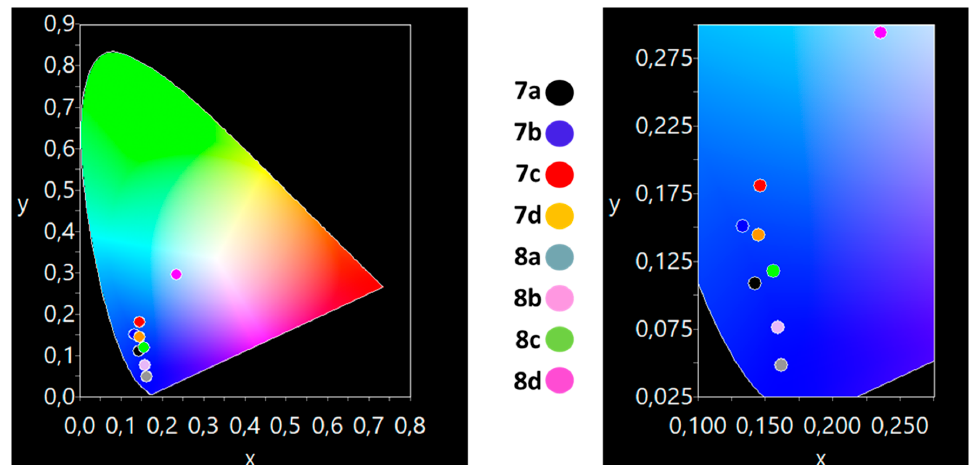
Figure 6. The CIE coordinates for the compounds 7a – d and 8a – d in DMSO solution, showing the deep-blue color of 8b .